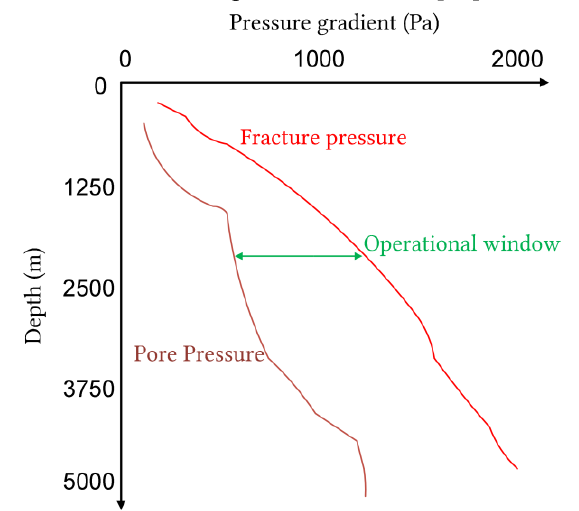
Fig. 2: Operational Window